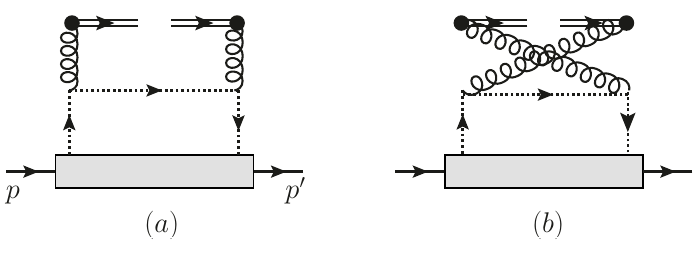
Figure 4 . The Feynman diagrams for the contributions with ghost